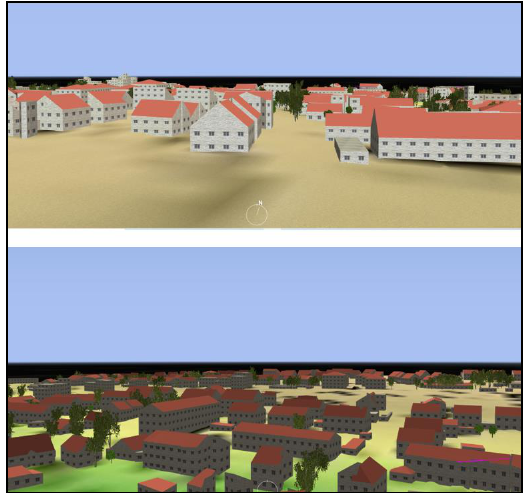
Figure 5. Closer view of the